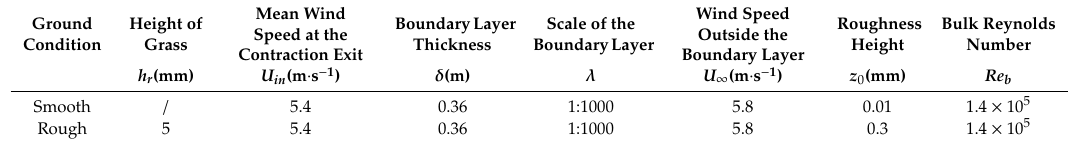
Table 5. Parameters in the simulations for the smooth and rough ground